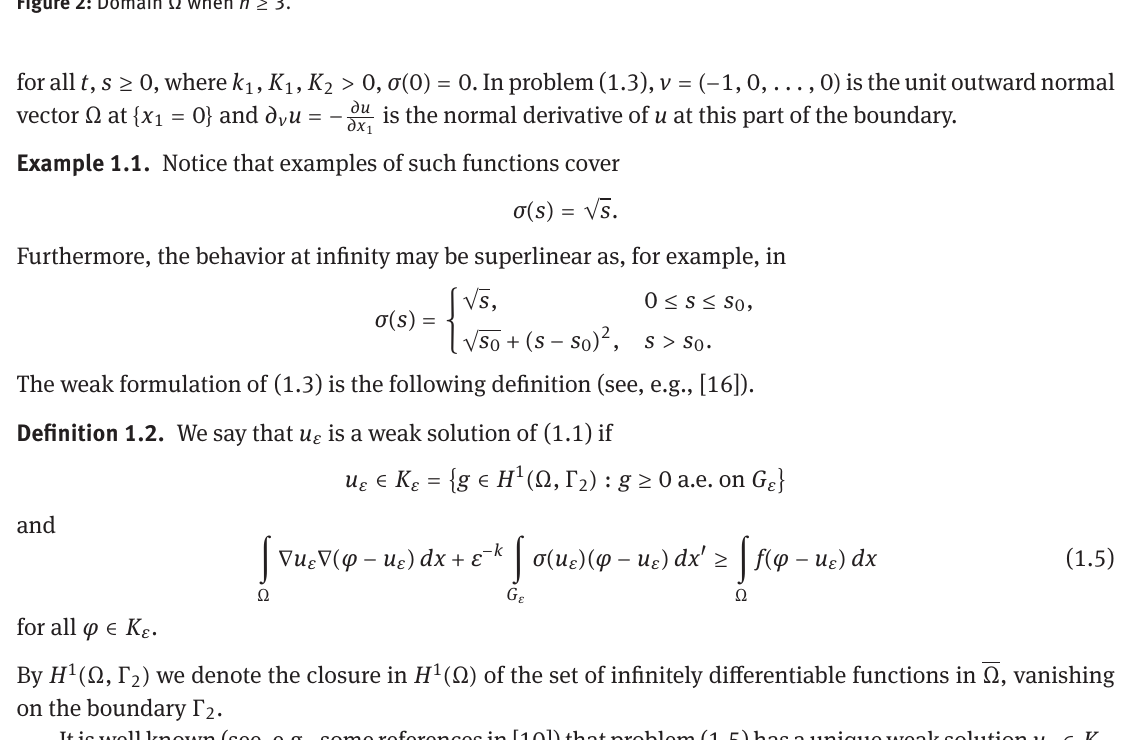
Figure 2: Domain Ω when n ≥